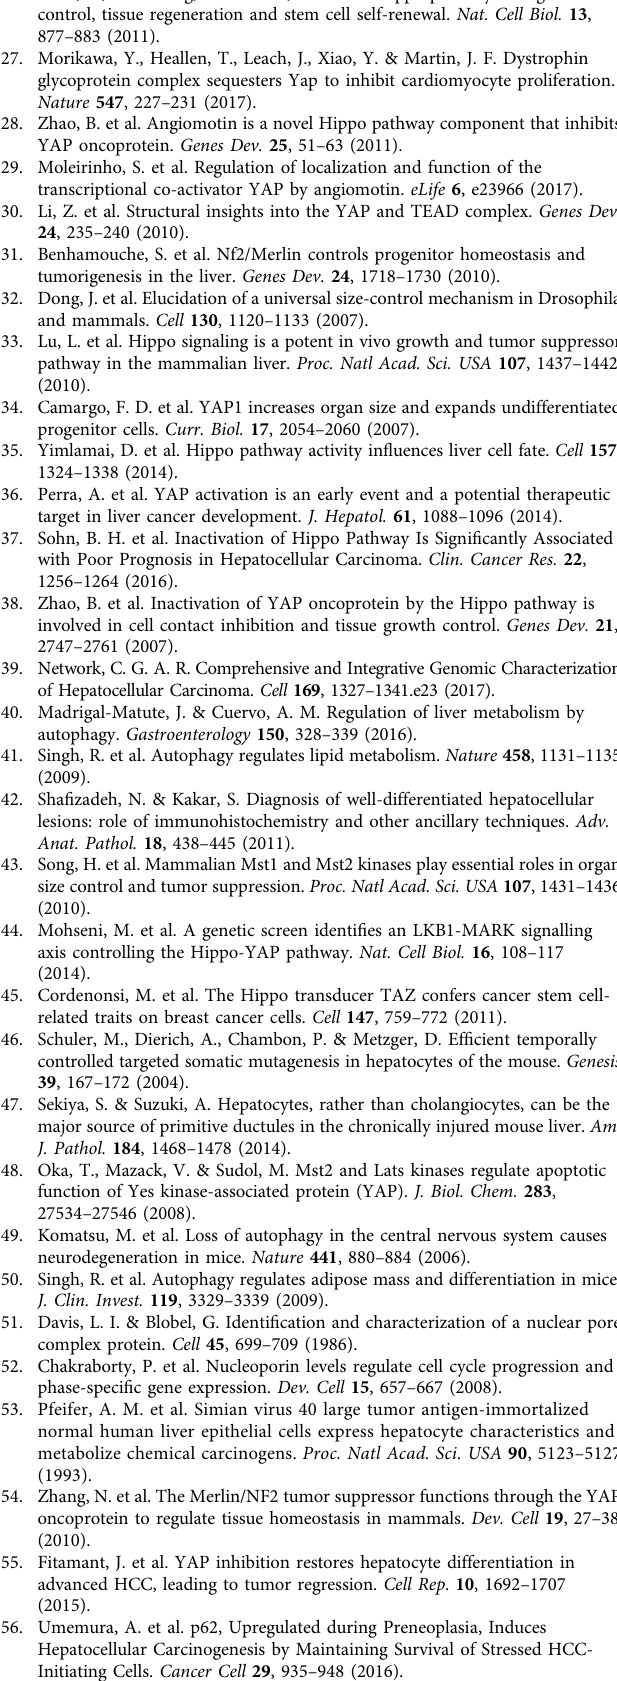
Data availability The Gene Expression Omnibus accession number for the transcriptome pro fi les reported in this paper is GSE67676. The Gene Expression Omnibus accession number for 72 NAFLD-affected livers is GSE49541. Genome-wide transcriptome pro fi les of 374 human HCC tissues were obtained from The Cancer Genome Atlas data portal